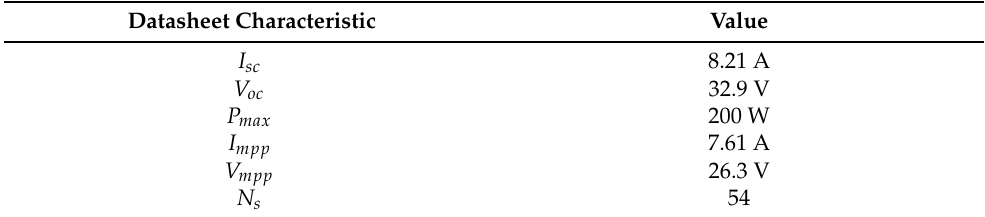
Table 3. Kyocera KC200GT datasheet characteristics and estimated model parameters [89]. Datasheet